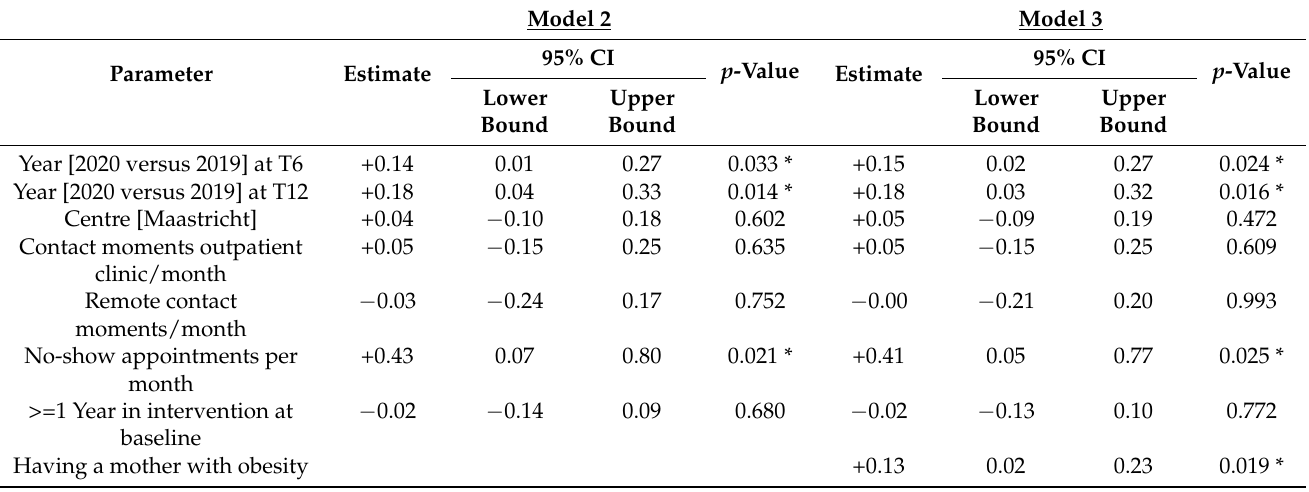
Table 3. Estimated fixed effects in the model for BMI z-score difference for children with overweight and (severe)